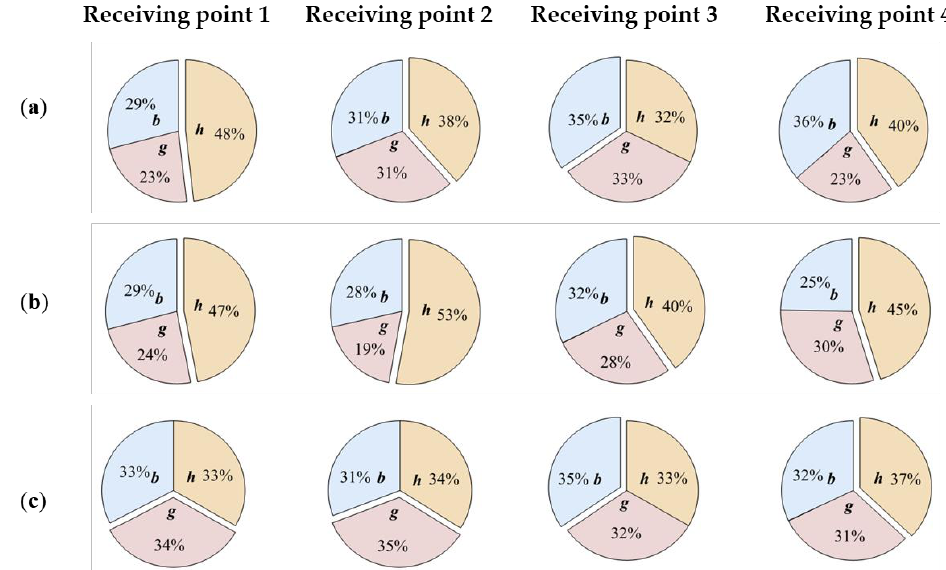
Figure 8. The spatial sound field auditory changes for the different space shape for the three musical sounds. The colors represent different spatial models: blue, red and yellow correspond to b, g, and h models. The size of the fan indicates the number of the stimuli selected at a receiving point in this space; the larger the number being selected, the larger the fan area. ( a ) Flute; ( b ) Violin; ( c ) Symphony.